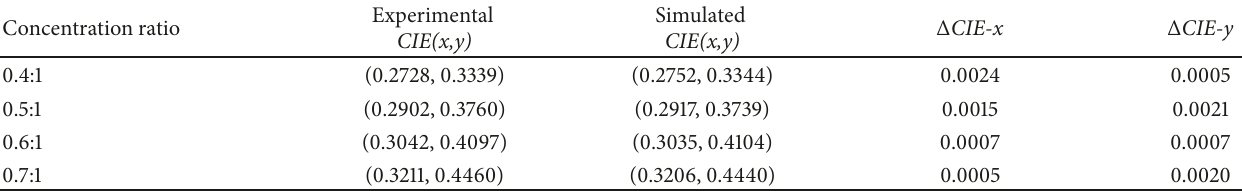
Table 2: Color coordinates of experiment and simulation at different mass ratios of green phosphor films. Concentration ratio